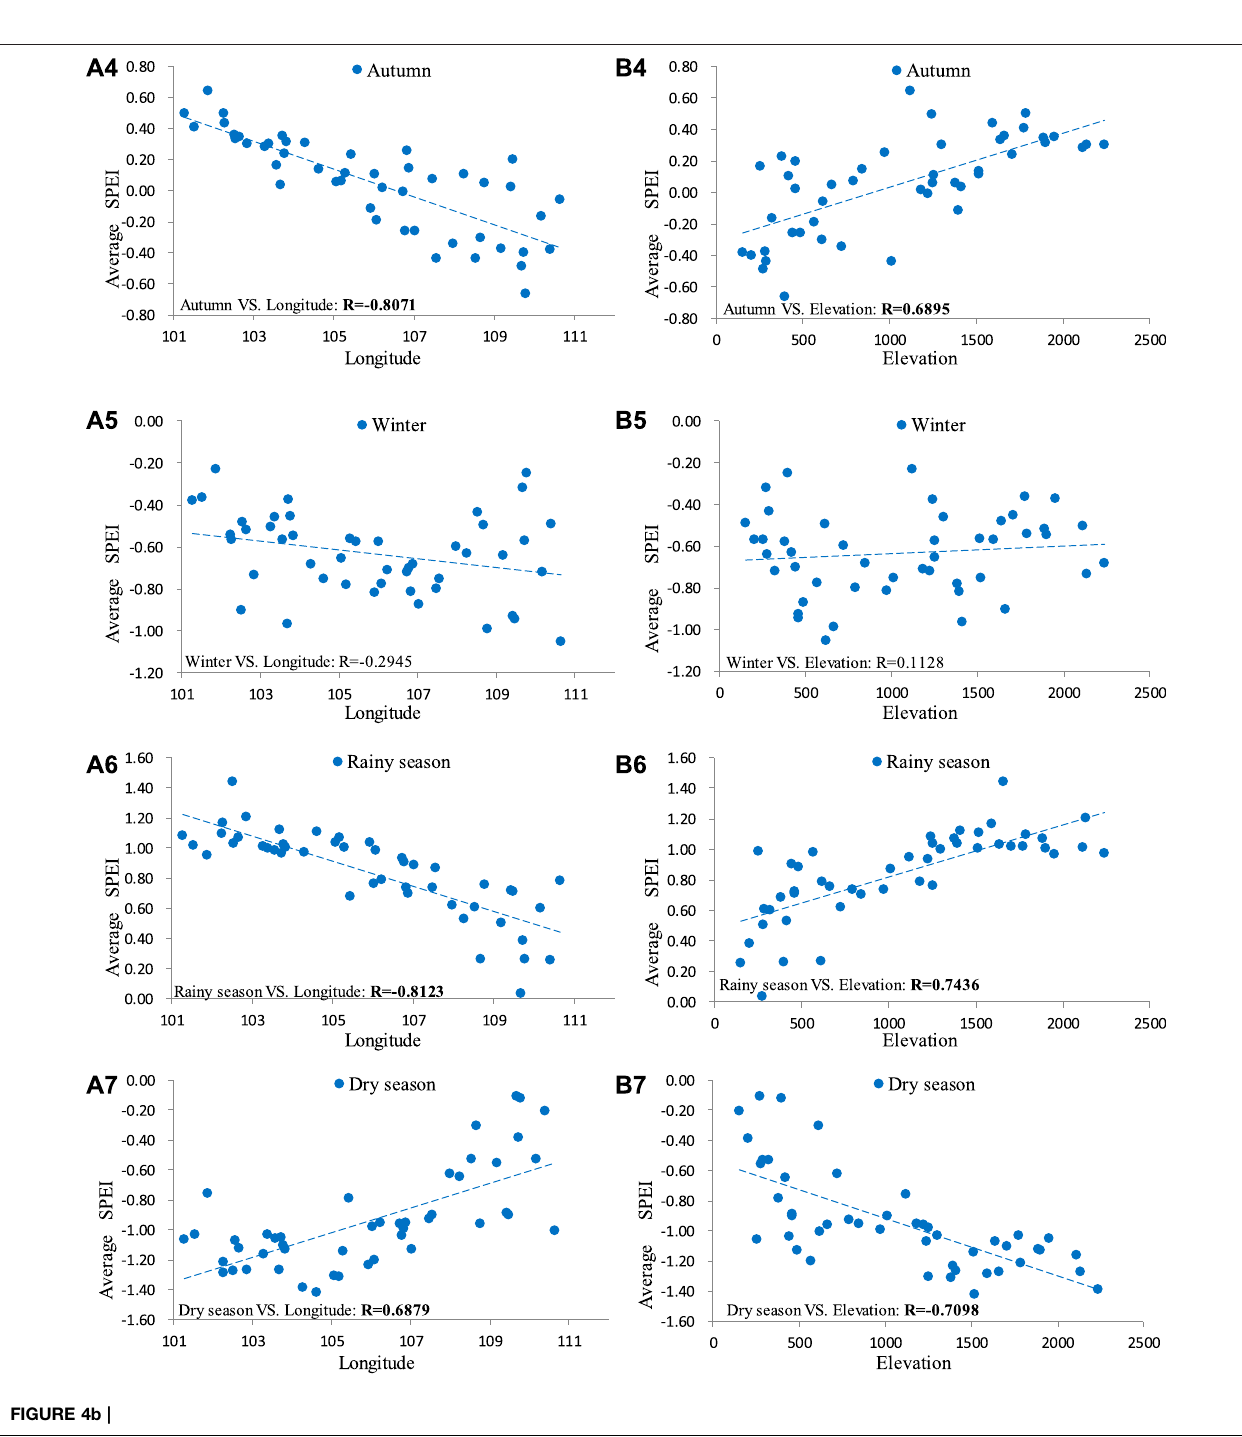
Frontiers in Environmental Science |